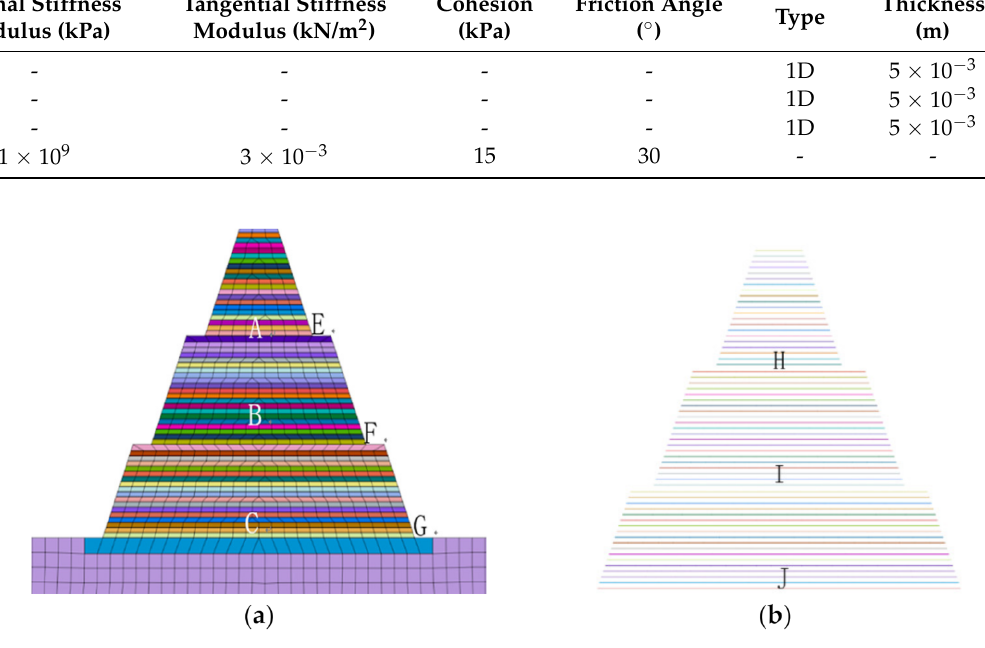
Figure 7. ( a ) Schematic diagram of filling monitoring points; ( b ) geogrid monitoring